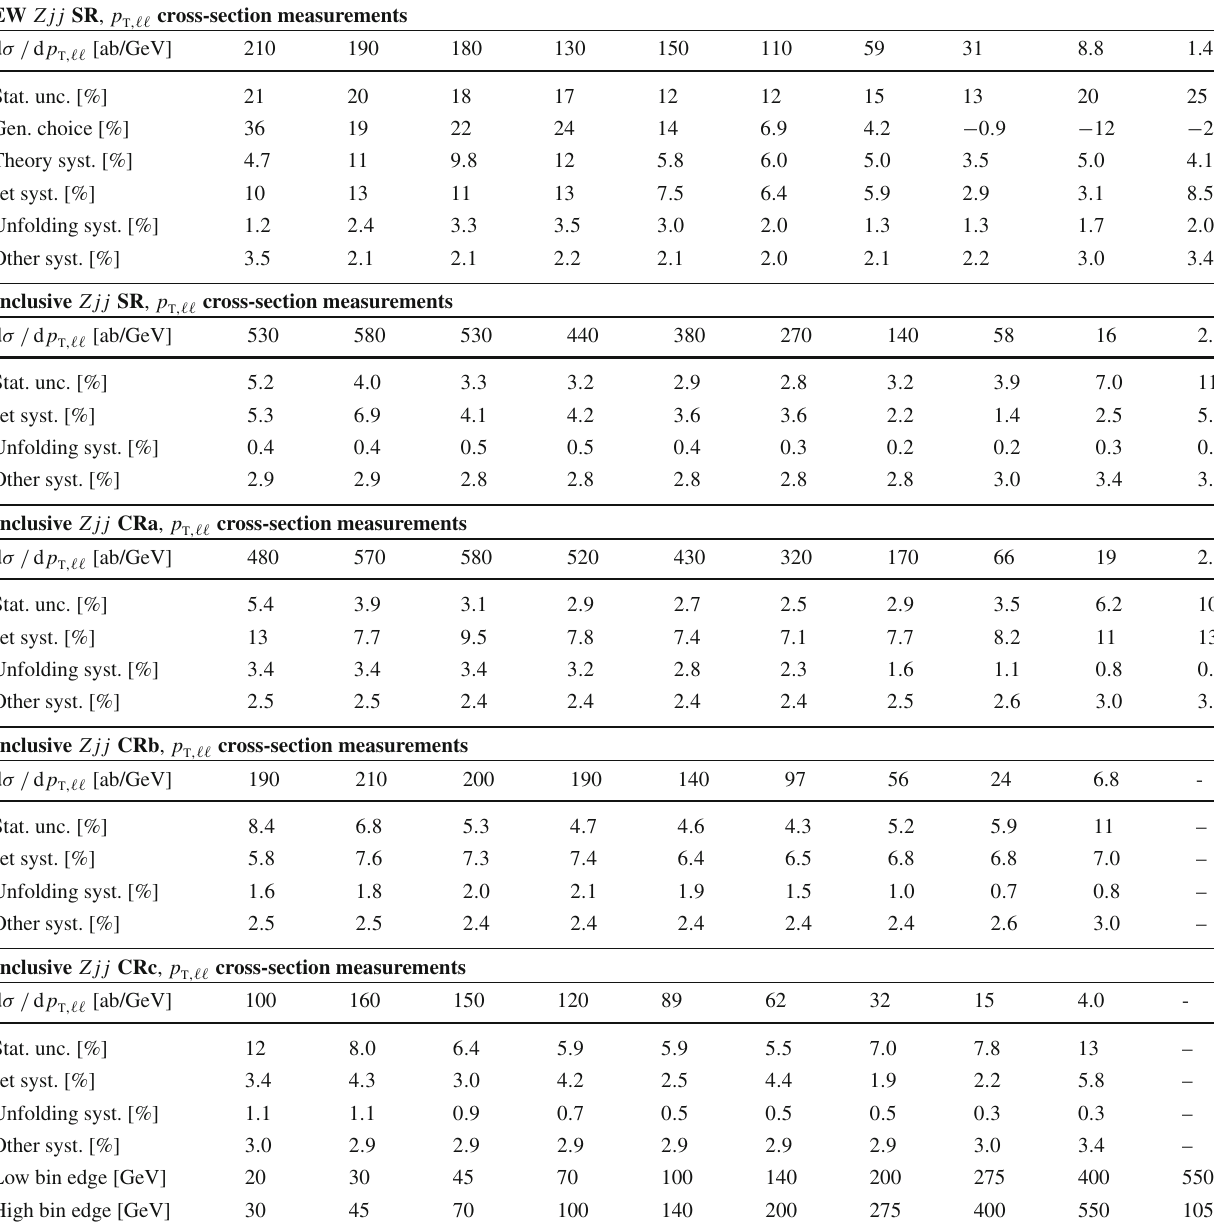
Table 7 Differential cross-section measurements for EW Zjj production and inclusive Zjj production as a function of p t ,(cid:3)(cid:3) . The EW Zjj measurements are performed in the signal region. The inclusive Zjj measurements are performed in the signal region and three control regions. The different sources of uncertainty are grouped together for each measurement, with a more granular breakdown of each uncertainty available in HEPDATA EW Zjj SR , p t ,(cid:3)(cid:3) cross-section